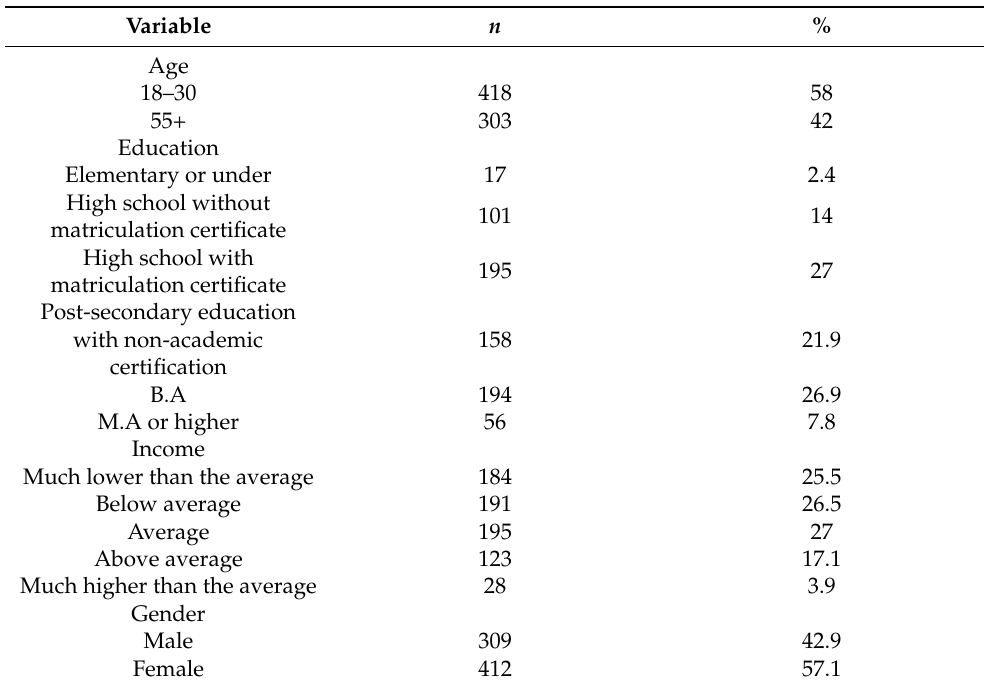
Table 1. Sample demographics ( n =